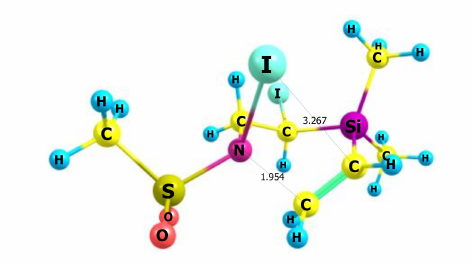
Figure 2. The structure of the transition state TS 18-19 , R = R 1 = CH 3